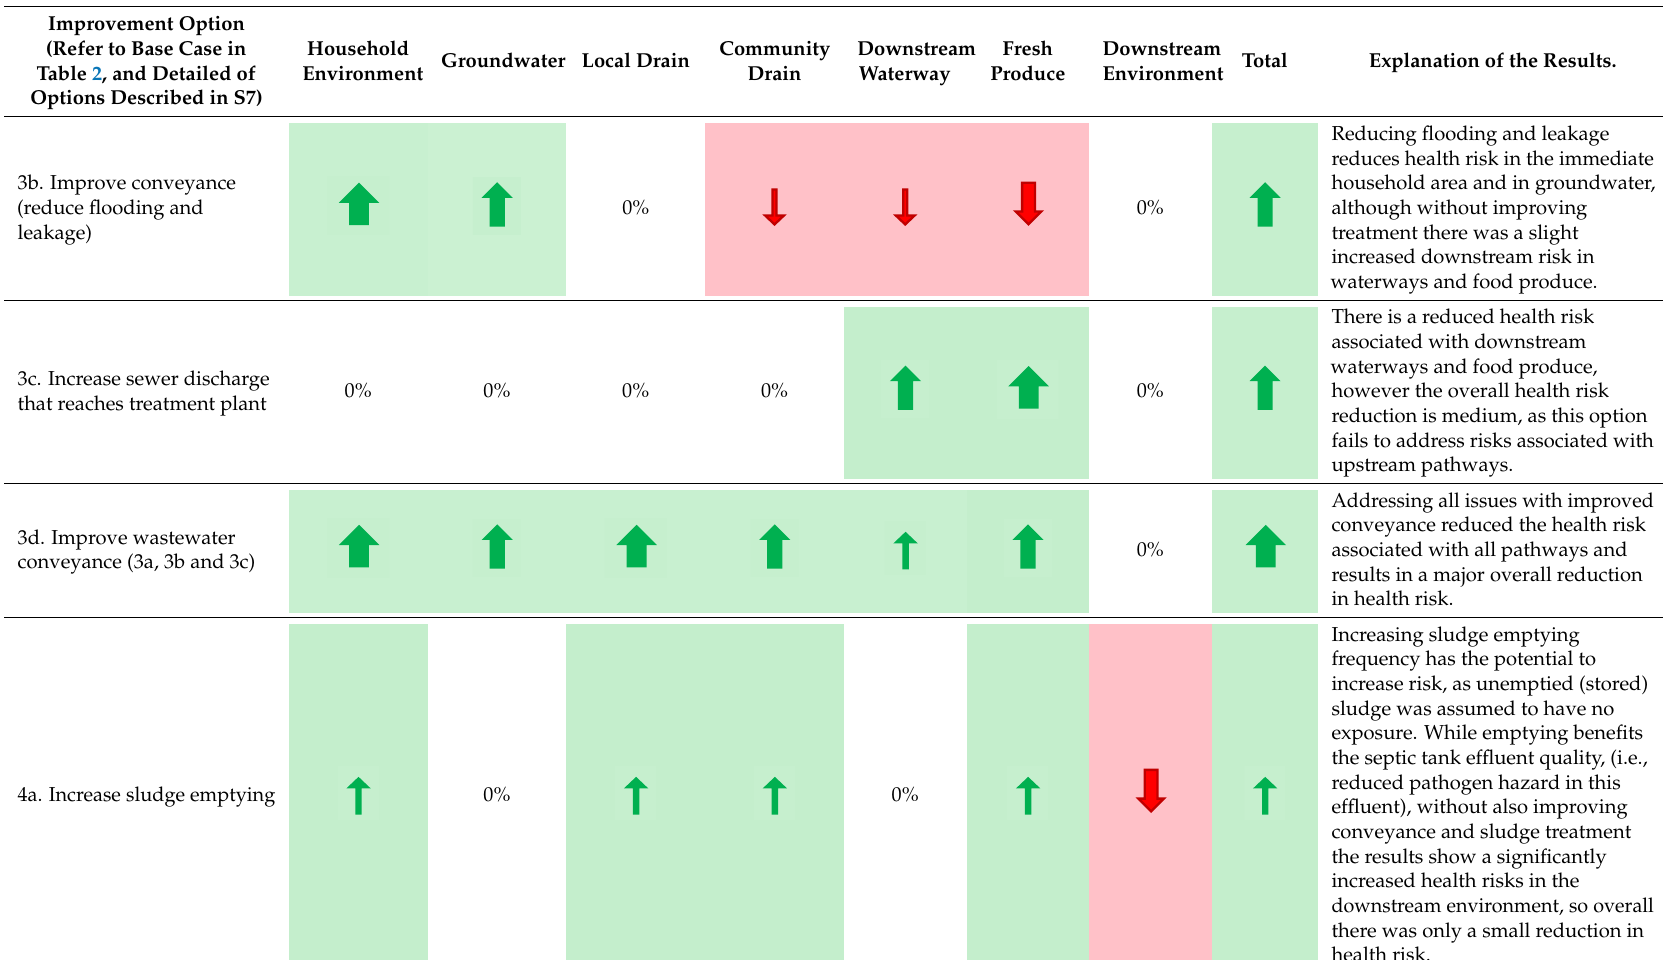
Table 3. Change in DALY per person per day from base case (based on exposure frequency and proportion of population exposed for Adults). Improvement Option (Refer to Base Case in Table 2, and